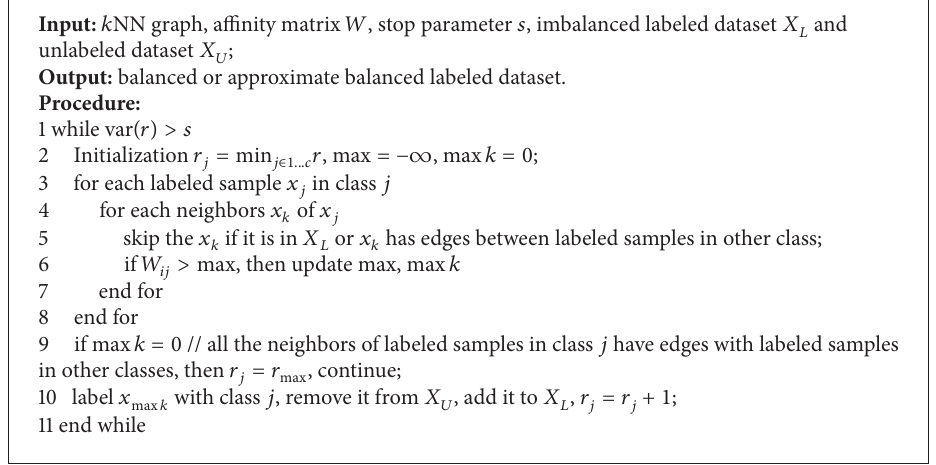
Algorithm 1: Iterative Nearest Neighborhood Oversampling (INNO).